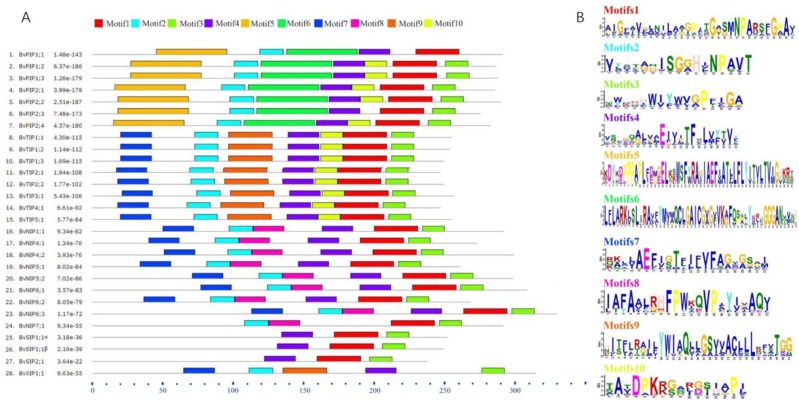
BvAQPs protein motifs identified by MEME.Using the complete amino acid sequences of BvAQPs. Combined p-values are indicated in (A) and different motifs were shown by different colors and numbered from 1 to 10 in (B).